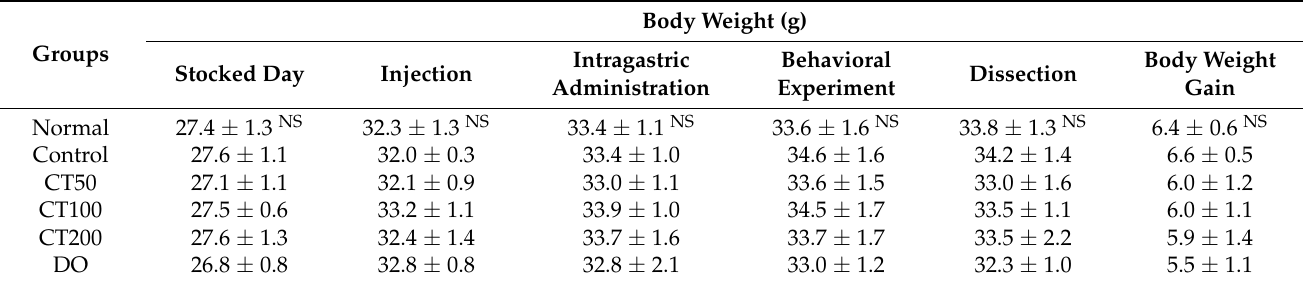
Table 1. Effect of combination with Carthamus tinctorius L. seed and Taraxacum coreanum (CT) on body weight and body weight gain against A β 25-35 -injected mouse.